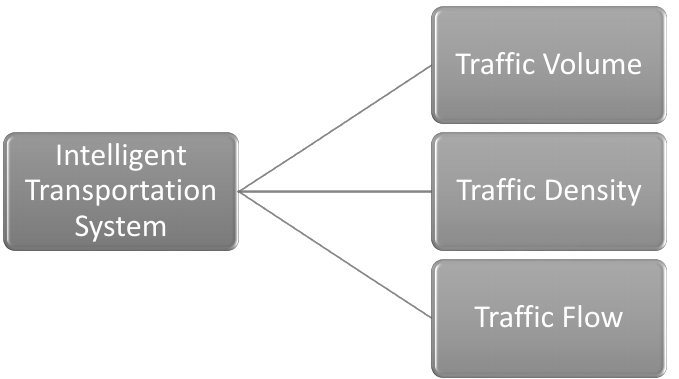
Figure 1. Data-collection aspects of intelligent transportation